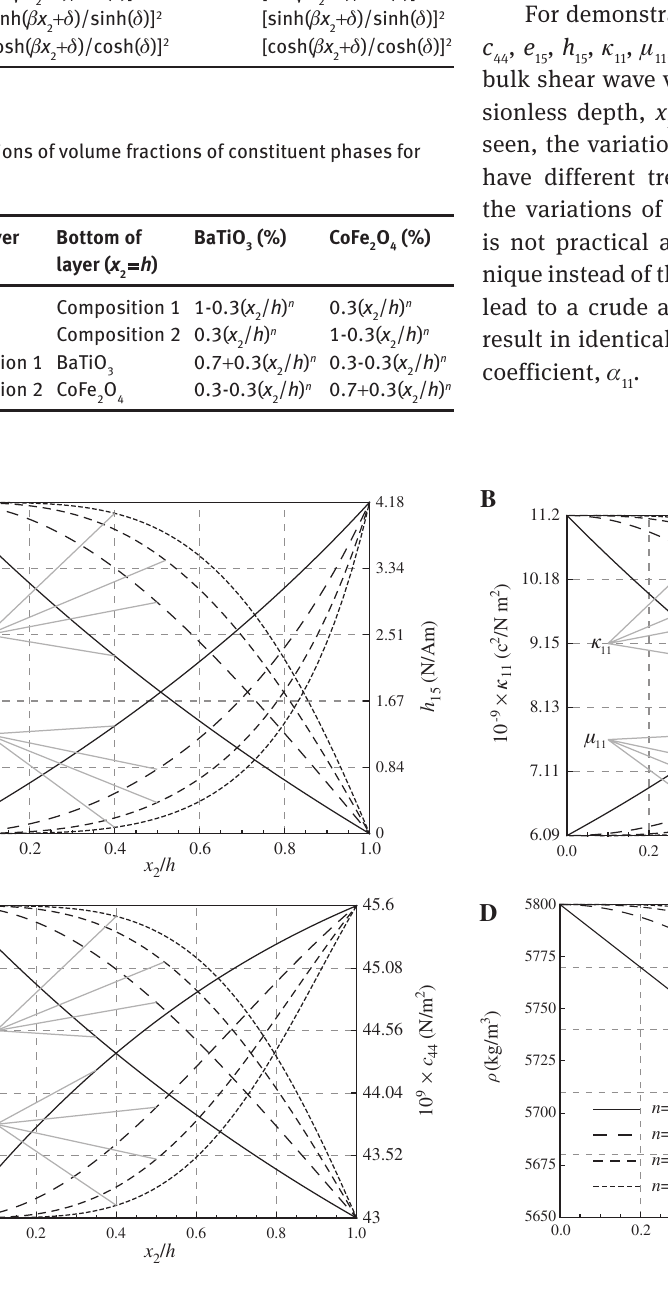
/ h , for profile G1, (A) e 2